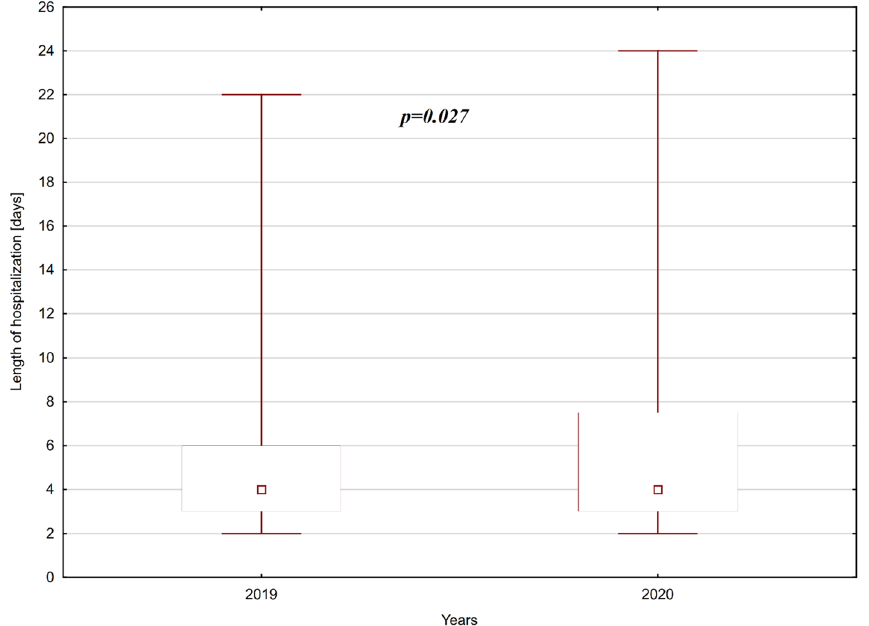
Figure 2. Length of hospitalization among patients treated with appendectomy in 2019 and 2020.